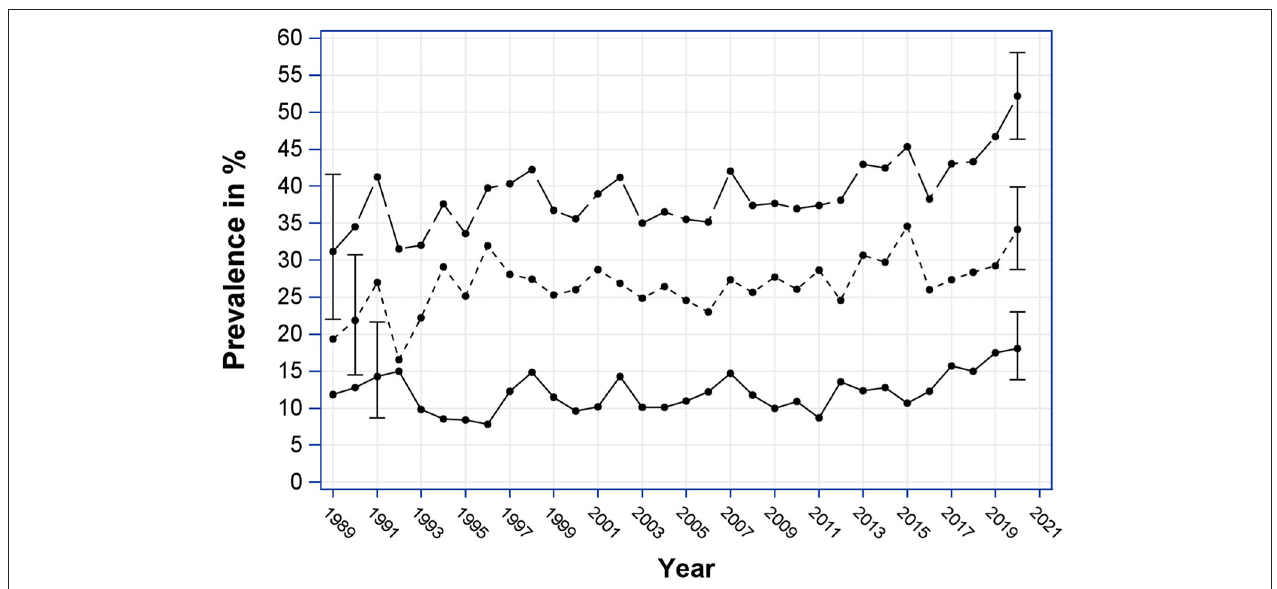
FIGURE 1 | Annual prevalence of onset-DKA (%) from 1989 to 2020, by severity with 95% confidence intervals. Long dashed, DKA; short dashed, mild DKA; solid, severe